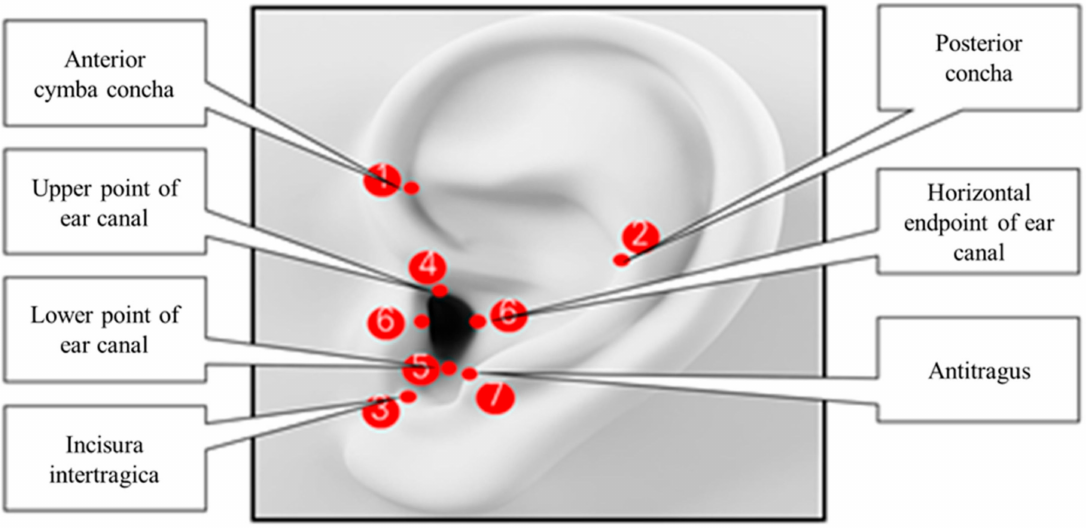
Figure 2. Selected points for measuring ear dimensions. Table 2. Ear dimensions related to the use of wireless